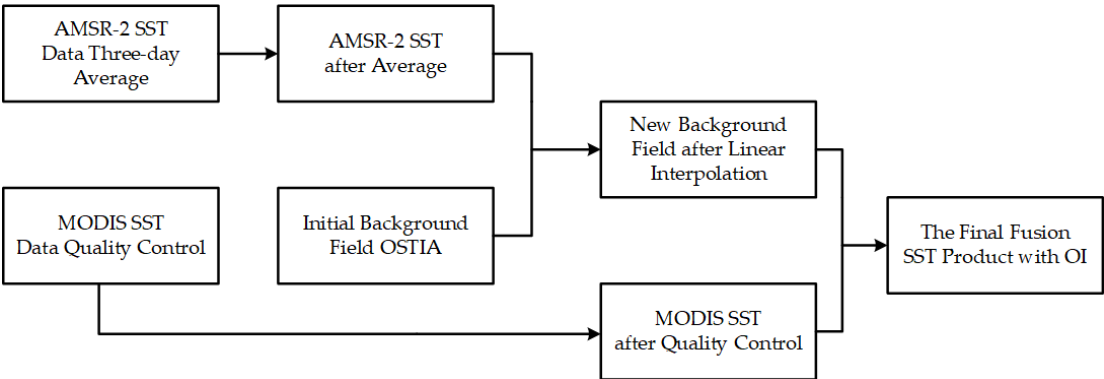
Figure 3. Fusion of MODIS and AMSR-2 SST data flow with the OI.